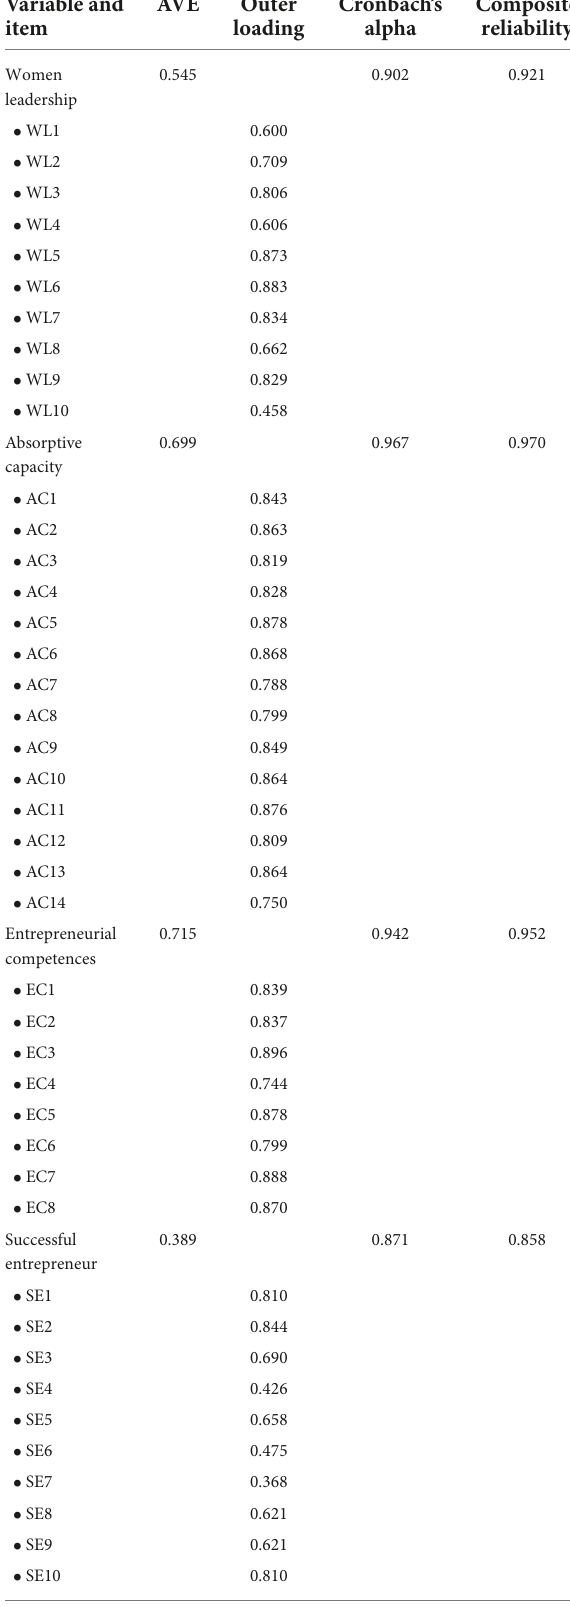
TABLE 1 Convergent validity and